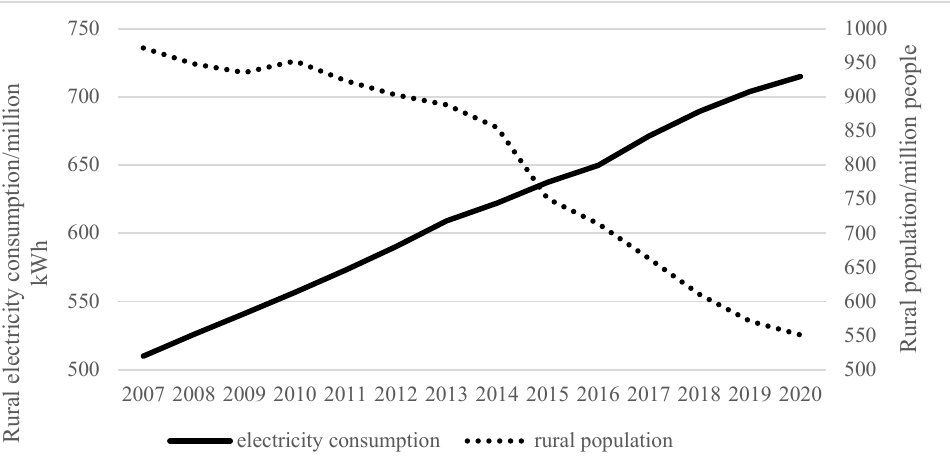
Figure 1. Change trend of rural permanent population and electricity consumption from 2007 to